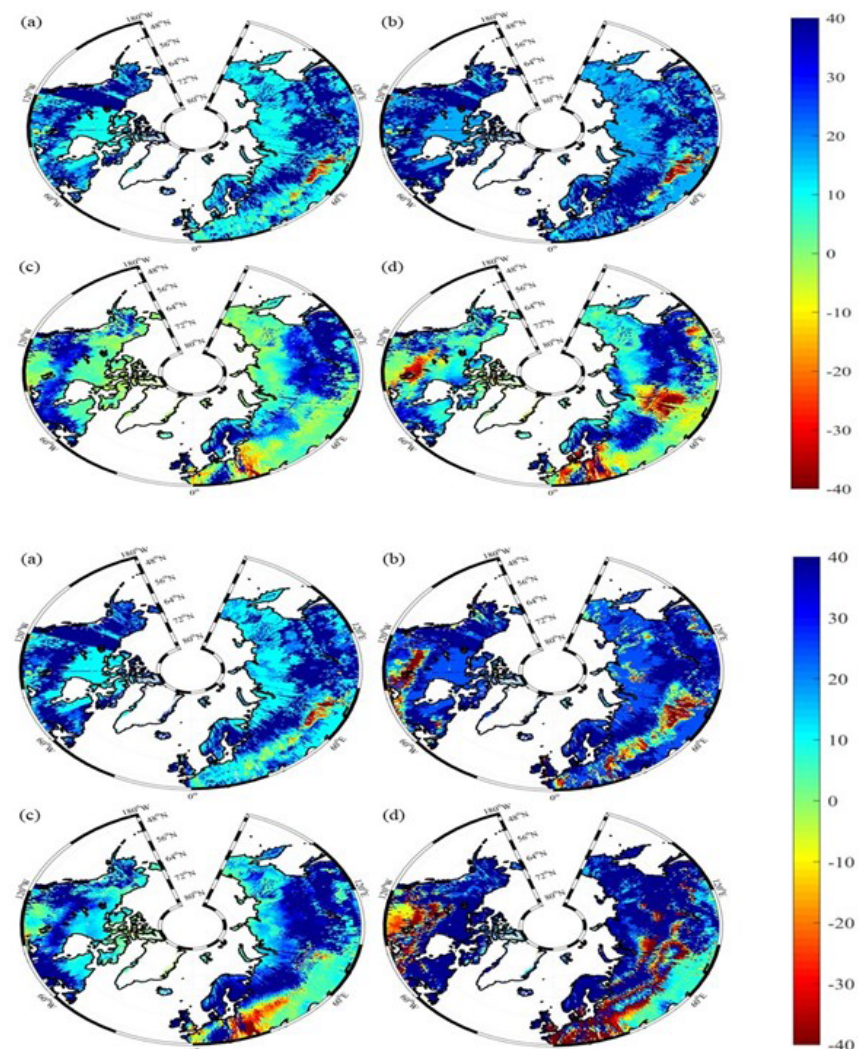
Figure 13. Spatial distribution of NEP simulated for the periods (a) 2000–2050 and (b) 2051–2099 by TEM_Moss and by TEM 5.0 (c, d) during the 21st century under the RCP2.6 scenario (upper panel) and RCP8.5 scenario (bottom panel). Positive values of NEP represent sinks of CO 2 into terrestrial ecosystems, while negative values represent sources of CO 2 to the